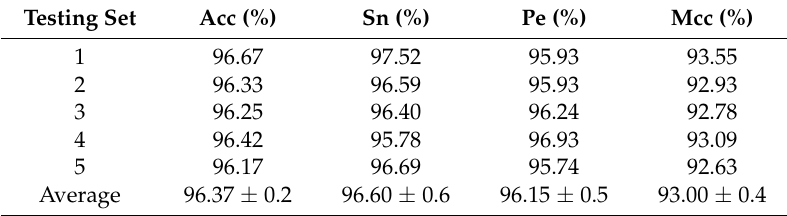
Table 1. Five-fold cross-validation results using our proposed method on the Yeast